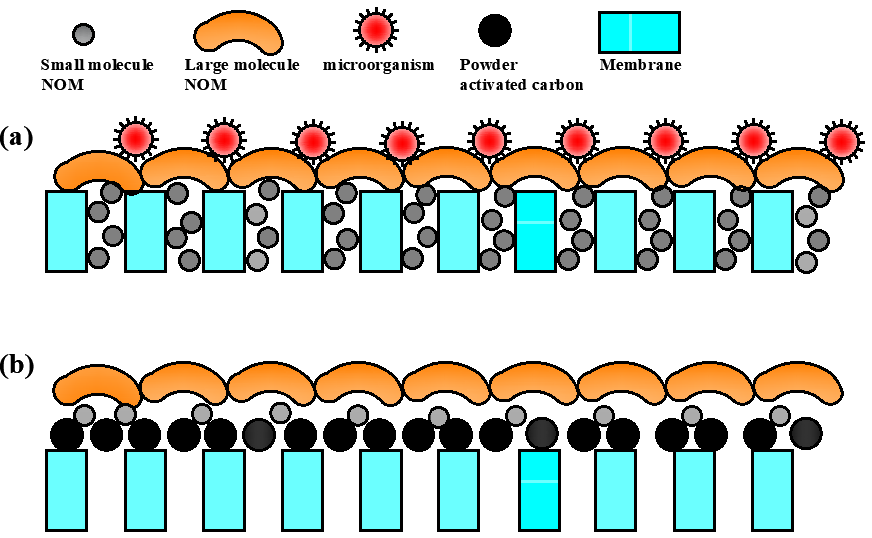
Figure 8. Fouling mechanisms of NF membrane by different pre-treatment. ( a ) SF+NF combined treatment; ( b ) SF+O 3 -BAC+NF combined treatment.